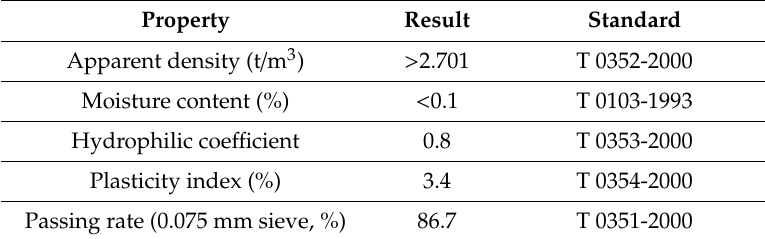
Table 2. Physical properties of mineral